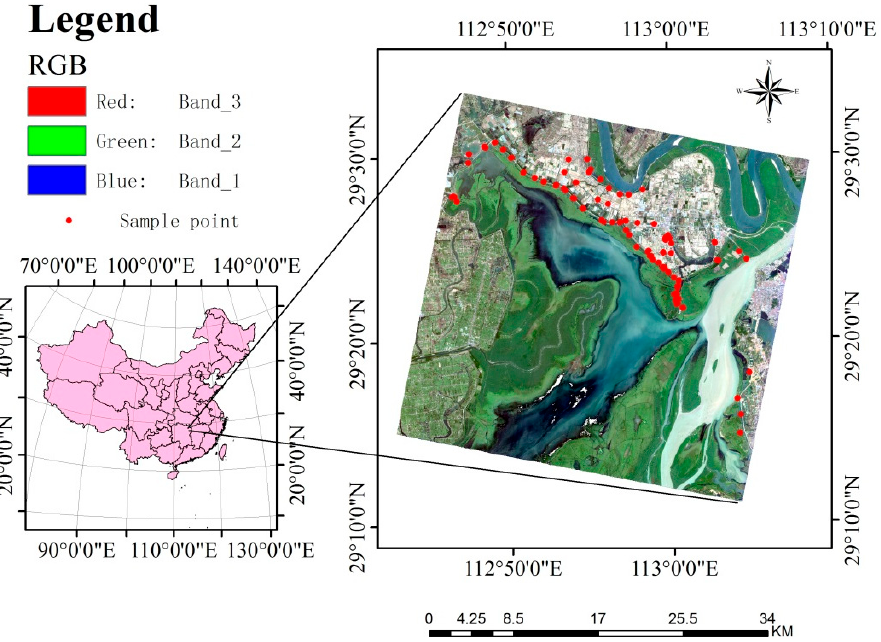
Figure 1. The study area–the East Dongting Lake and spatial distribution of sample plots shown in a natural color composite image from Gaofen-1 sensor ( right ); and its location in China ( left ).